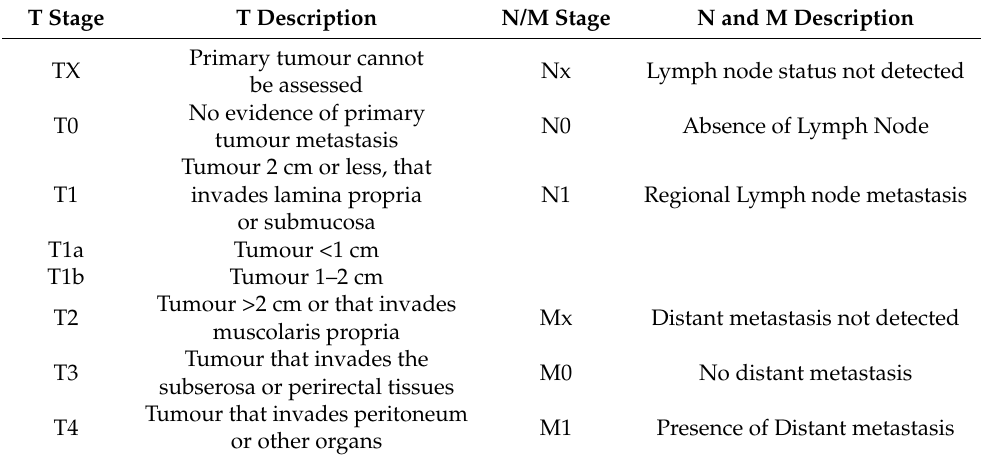
Table 2. TNM staging for Rectal NETs according to American Joint Committee on Cancer